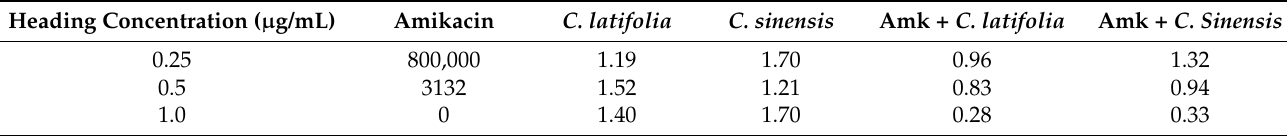
Table 2. Viable counts for some of the individual treatments and combinations.